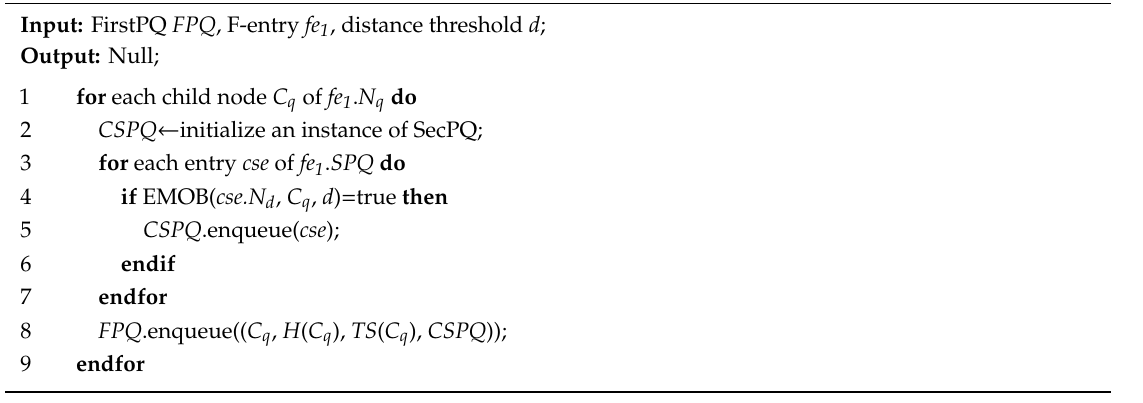
Algorithm 3. TRA-Q( FPQ , fe 1 , d )